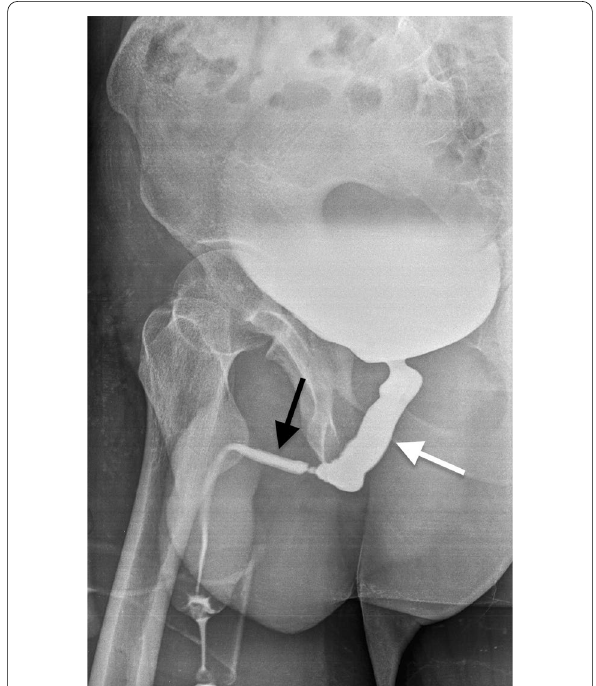
Fig. 23 Urinary disorders in a 72-year-old man after pelvic RT due to prostate cancer. Retrograde cystourethrogram, oblique view, shows dilatation of the membranous urethra (white arrow) due to a long stenosis of the bulbar segment (black